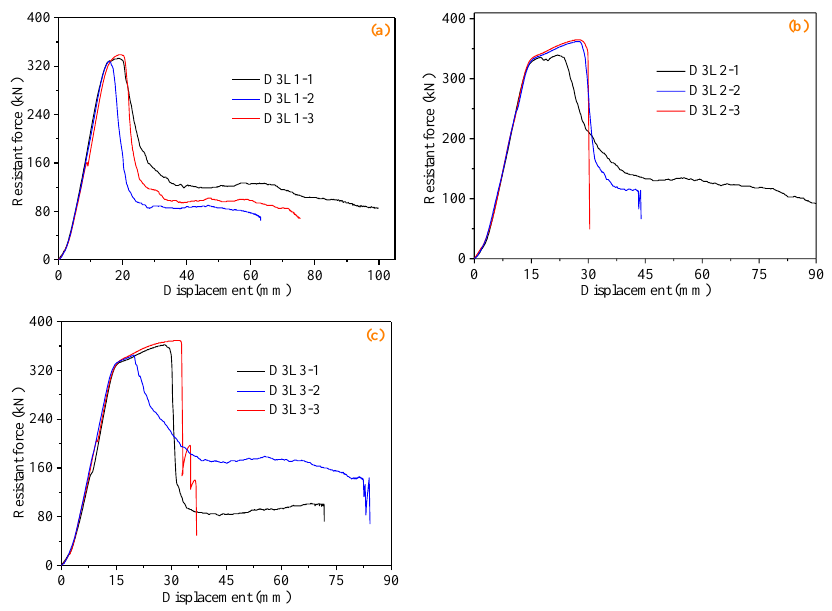
Figure 10. Mechanical response of flexible bolts with different Ø42 mm locking casing lengths: ( a ) 100 mm, ( b ) 120 mm, and ( c ) 140 mm.